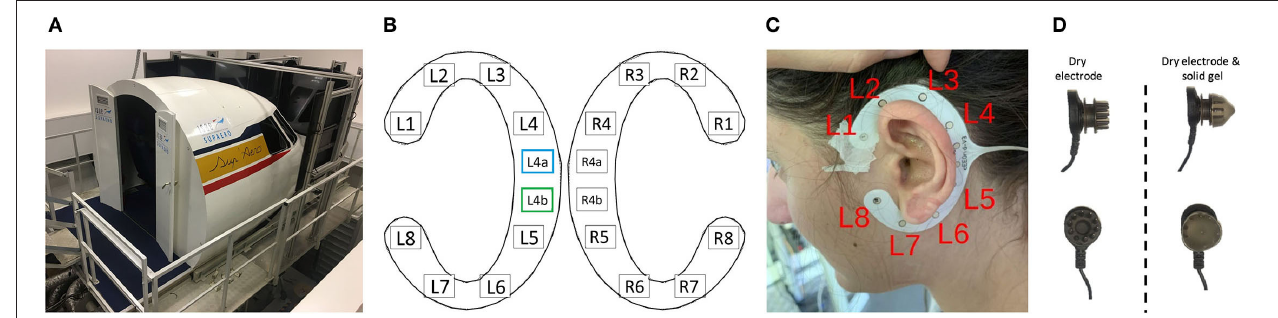
FIGURE 1 | (A) Three-axis motion flight simulator at ISAE-SUPAERO. (B) Localization of the cEEGrid electrodes for both ears with recording reference (blue) and DRL (green) electrodes indicated. Electrodes R4a and R4b on the right grid were not recorded on our set-up. Layout adapted from the cEEGrid plugin (Martin G. Bleichner, 2019) in EEGLAB (v.2019.1) (Delorme and Makeig, 2004). (C) Localization of the left ear grid when fitted around the ear of a participant after cleaning and preparing the skin of the participant. (D) Illustration of a dry electrode with pins from the Enobio device (left) and the same electrode encapsulated with solid gel that has the consistency of silicone (right) to avoid discomfort or even